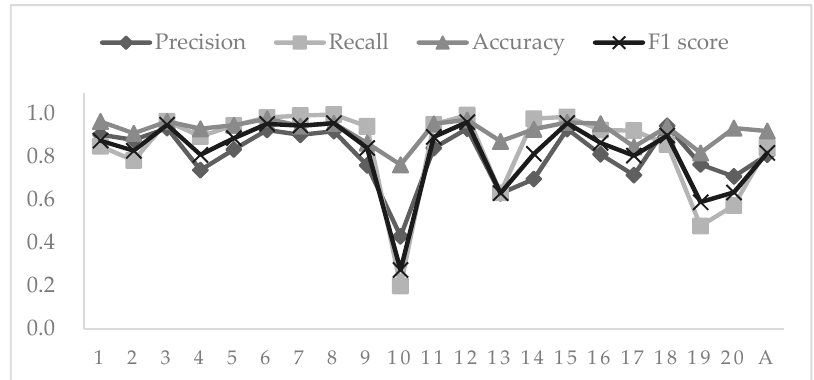
Figure 6. Accuracy assessment based on four indexes. A stands for average, and numbers 1–20 indicate the serial numbers corresponding to the verification samples.